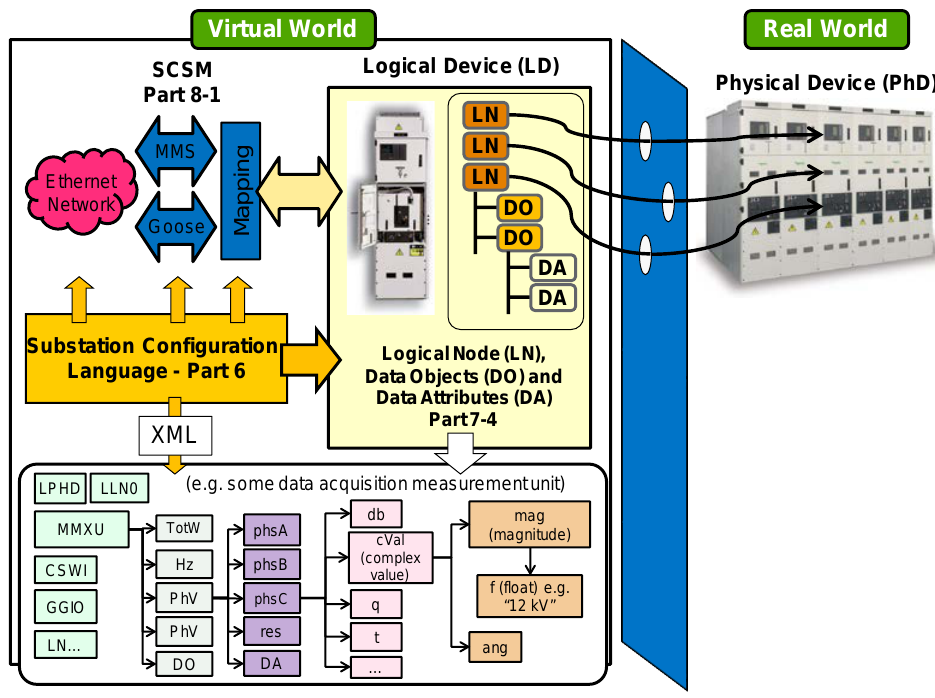
Figure 7. Data model of MV cubicle and its protection relay.